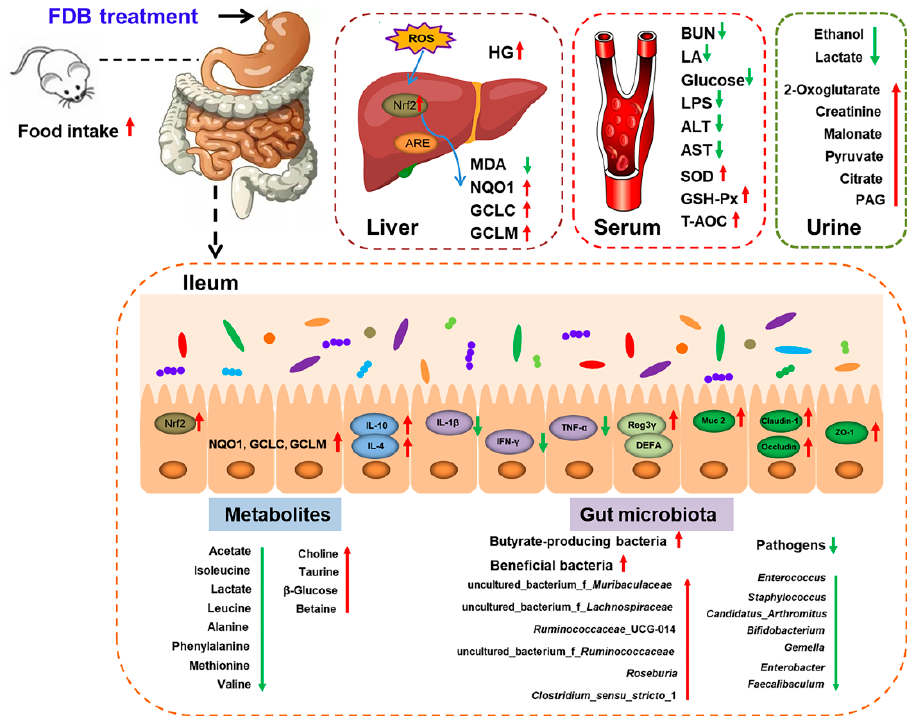
Figure 6. Overview of the effects of FDB on the fatigue related parameters, small intestine microbiota and metabolites in intense exercise mice. BUN: urea nitrogen; LA: lactic acid; LPS: lipopolysaccharide; ALT: alanine aminotransferase; AST: aspartate aminotransferase; HG: hepatic glycogen; SOD: superoxide dismutase; GSH-Px: glutathione peroxidase; T-AOC: total antioxidative capacity; MDA: malondialdehyde; PAG: phenylacetyl